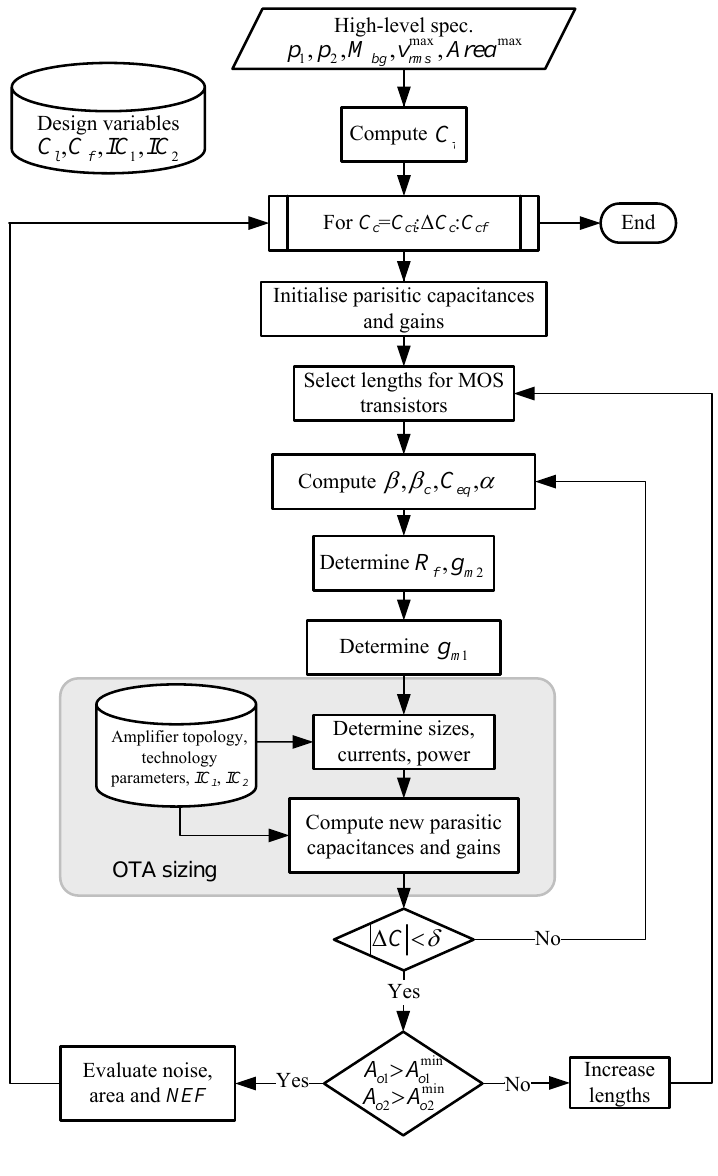
Figure 8. Proposed sizing